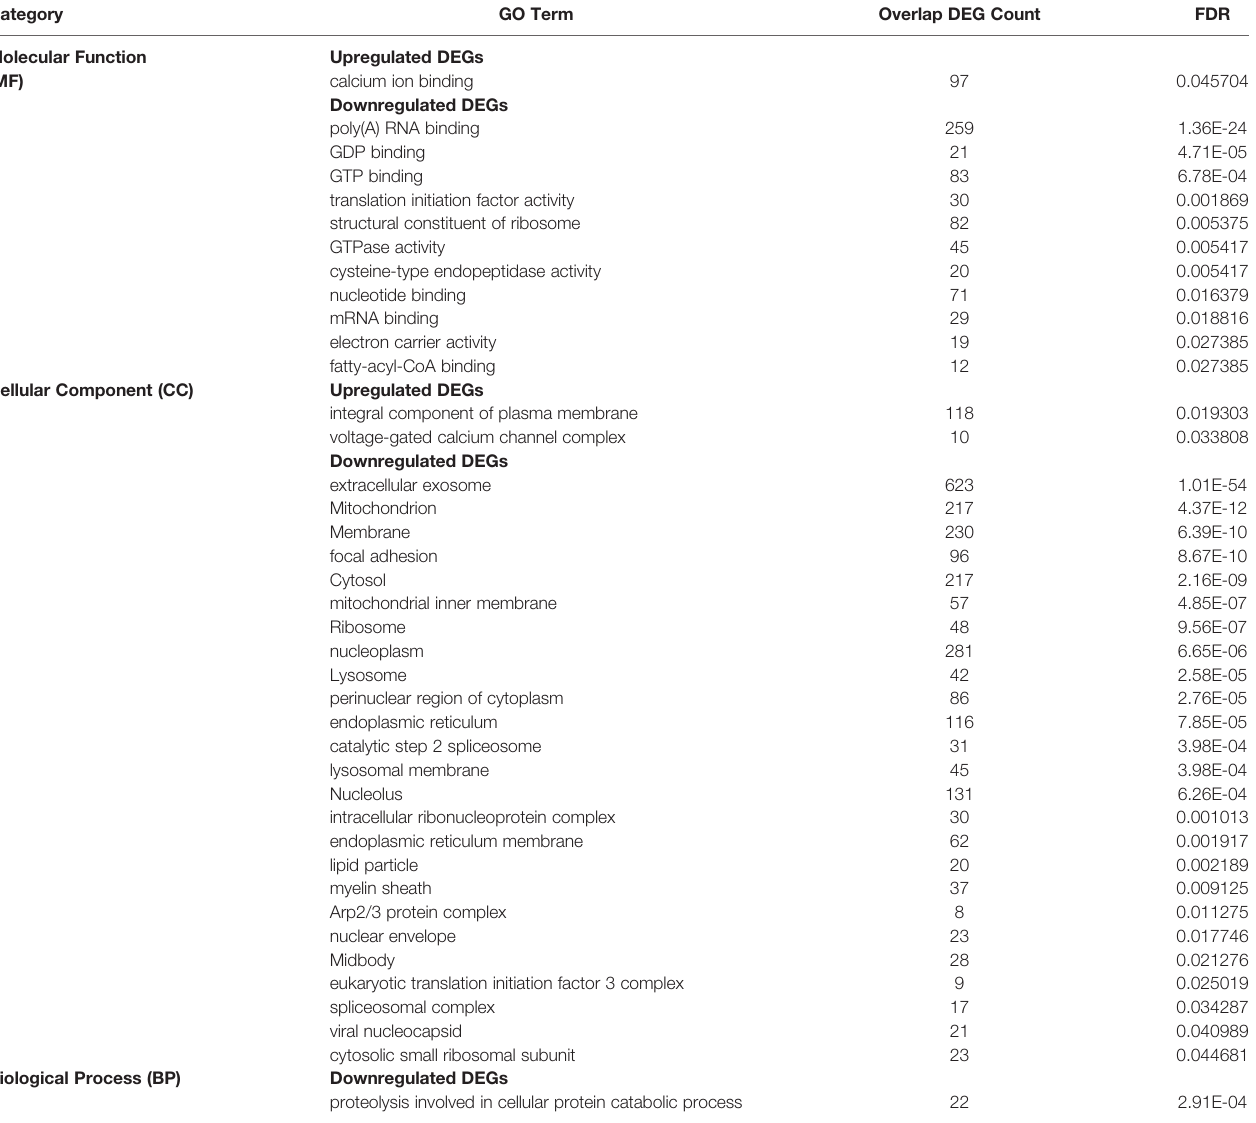
TABLE 2 | Signi fi cantly Enriched GO Terms For Differentially Expressed Protein Coding Genes.